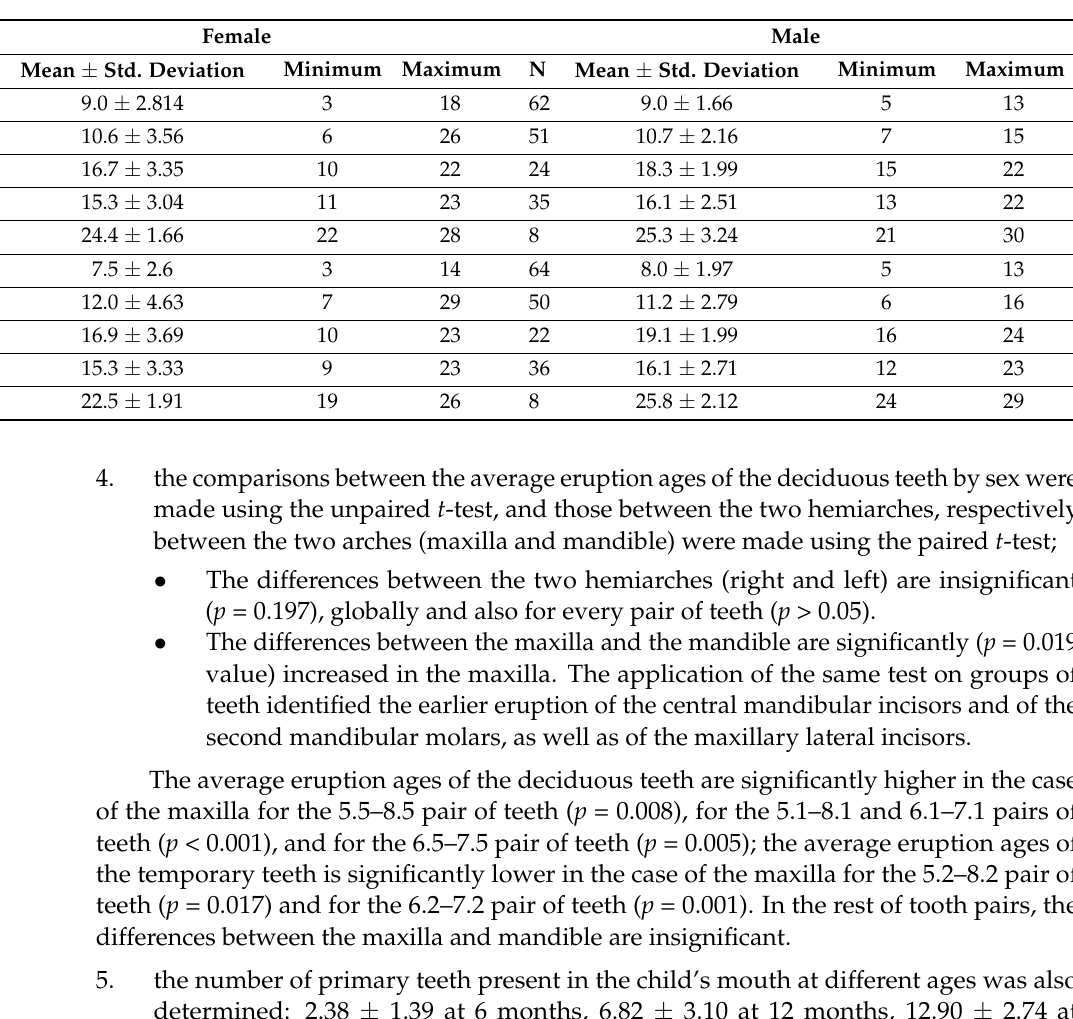
Table 4. The average eruption ages of the deciduous teeth by